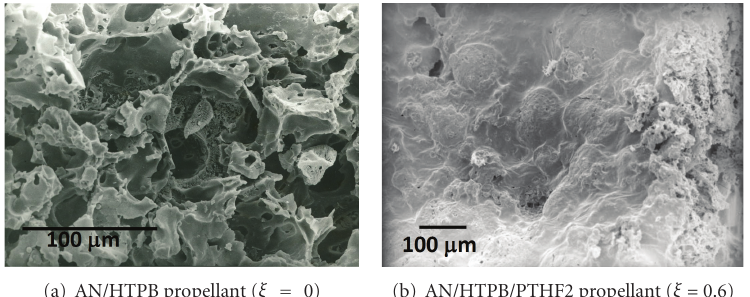
Figure 3: SEM photographs of burning surface of propellant quenched at